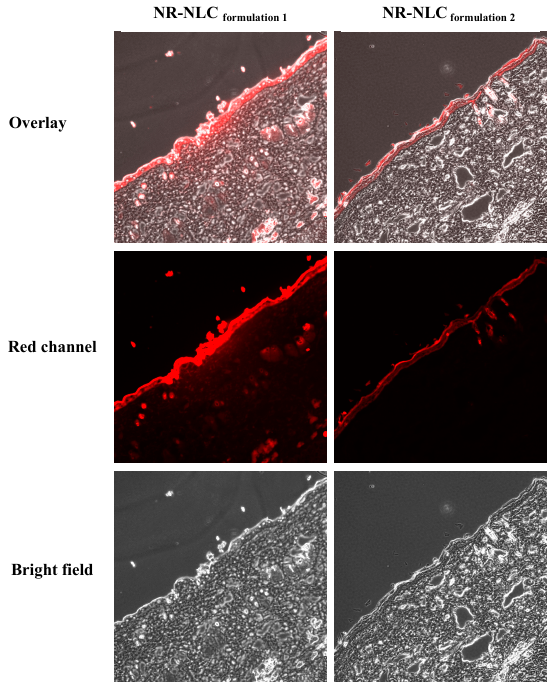
Figure 5. Confocal laser scanning microscopy (CLSM) images of vertical slices (10 μ m) of rat skin, 4 h after the administration of Nile red-loaded NLC (NR-NLC) formulation 1 (109.7 nm) and NR-NLC formulation 2 .